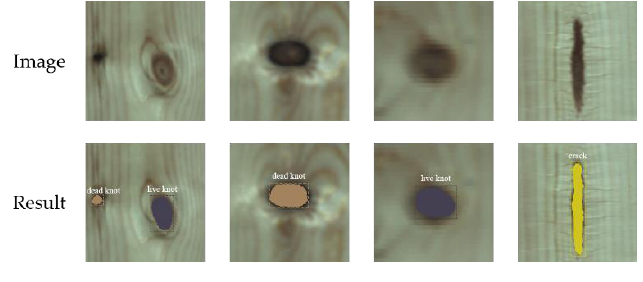
Figure 12. Detect results of the GM-Mask R-CNN. Table 7. Confusion matrix of defect type OCA detected by the proposed method.